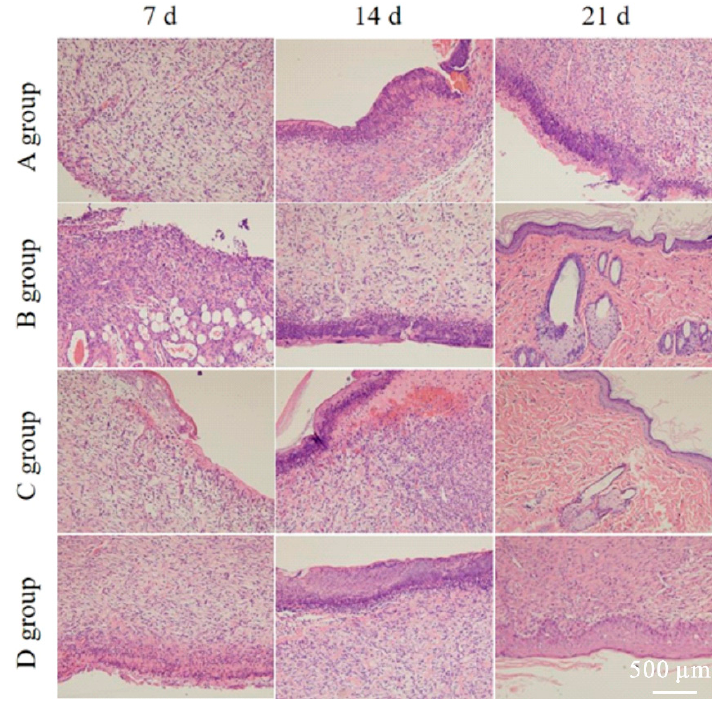
Figure 3. H&E staining results of traumatic tissue. Notes: ( A ): model group; ( B ): dracorhodin perchlorate inflammation targeting emulsion gel group; ( C ): dracorhodin perchlorate non-targeting emulsion gel group; ( D ): positive group. Scale bar is 500 μ m.